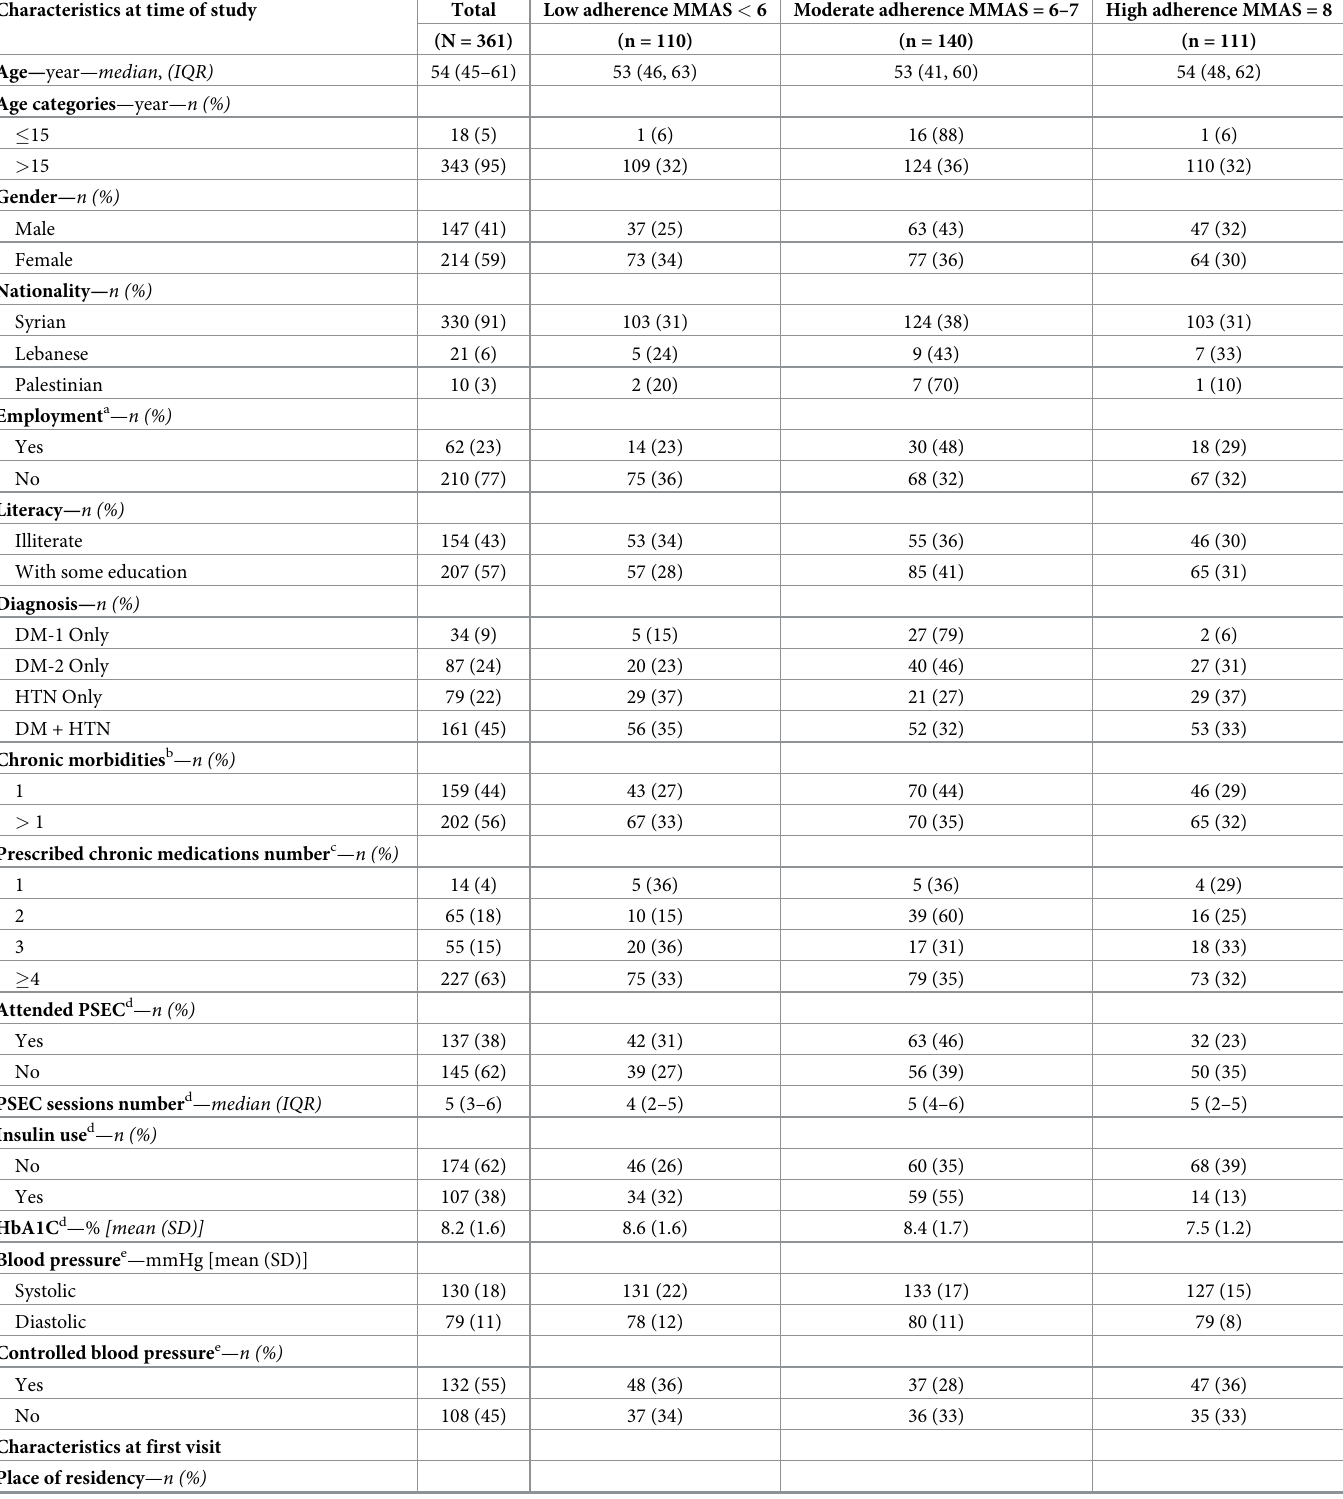
Table 1. Description of the general characteristics of the participants, stratified by their level of adherence, Shatila primary care clinic, Beirut, October 2018. Characteristics at time of